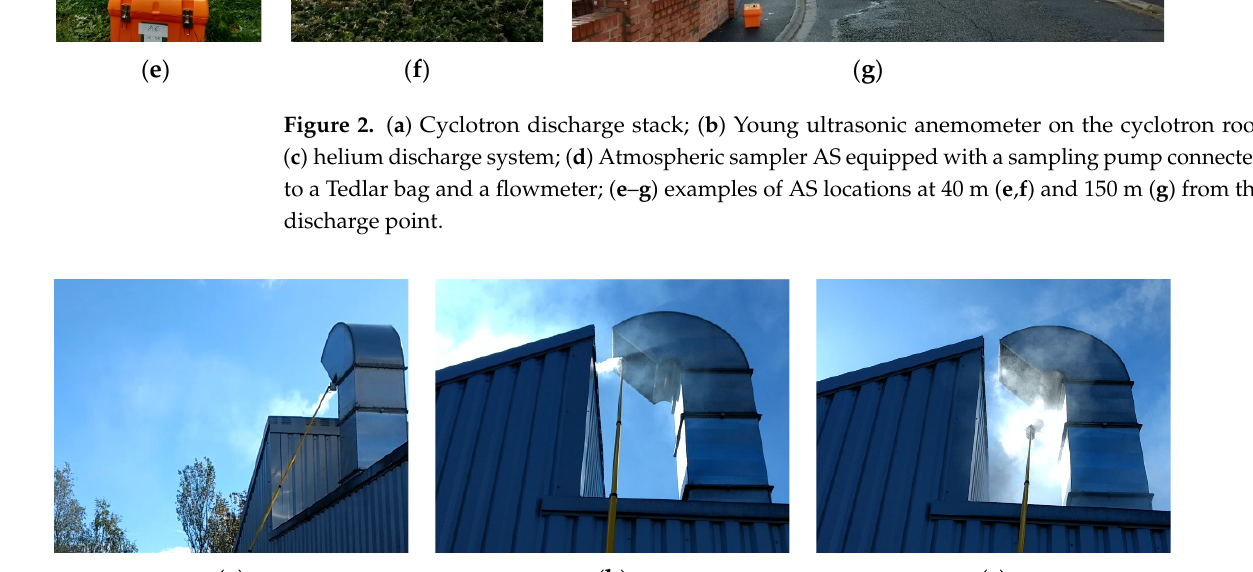
Figure 3. ( a , b ) Example of the dispersion of smoke discharged in the upper part and ( c ) in the lower